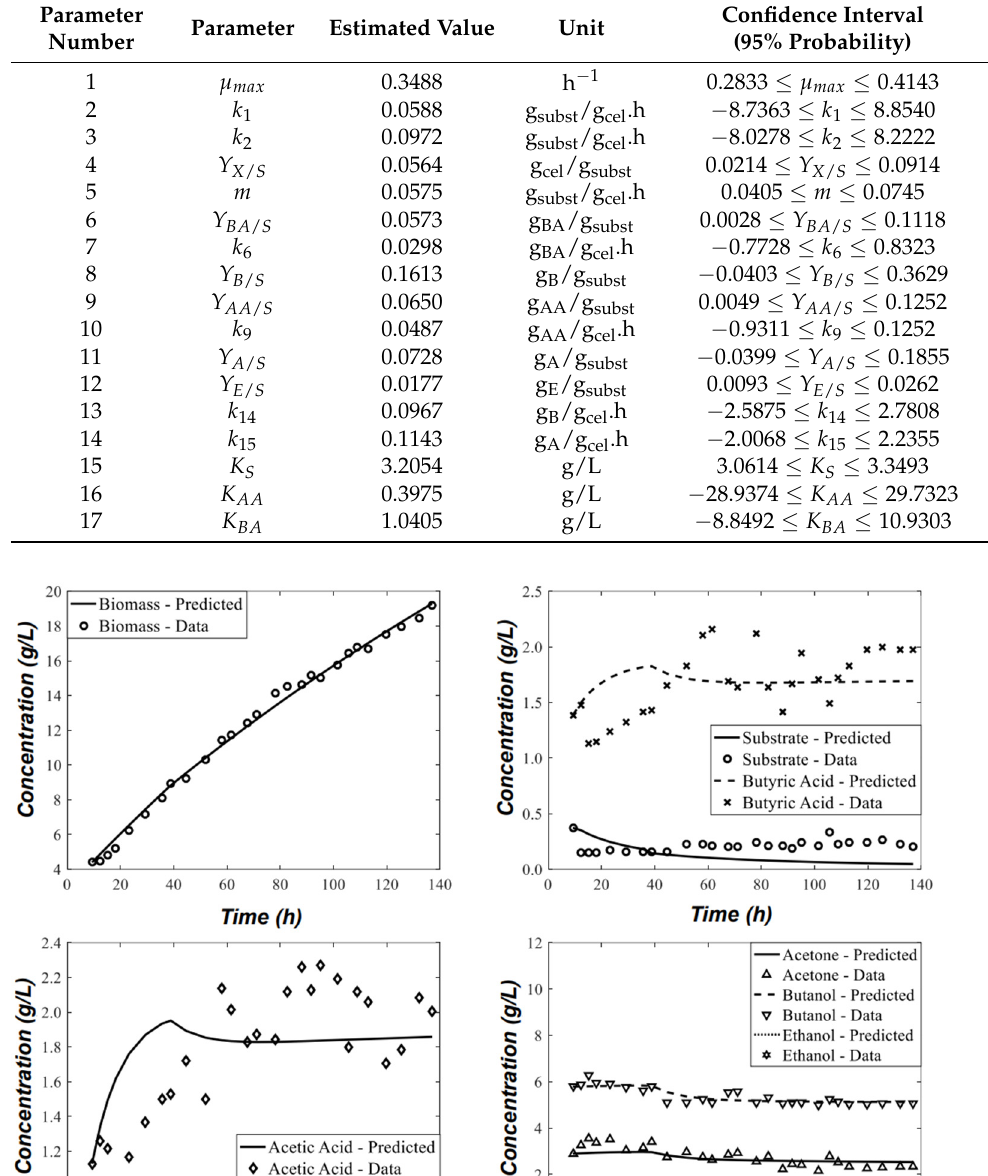
Table 3. Estimated parameters for the Base-Model with 17 parameters.